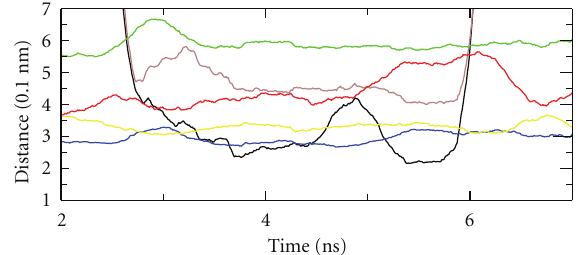
Figure 5: Distance versus time for selected pairs of atoms in the catalytic site: red: W126 HE1-C36 SG; yellow: Q71 HE2-C36 SG; blue: N127 HD2-C36 SG; green: N127 OD1-C36 HG; black: PEO H-N127 O; violet: PEO O-C36